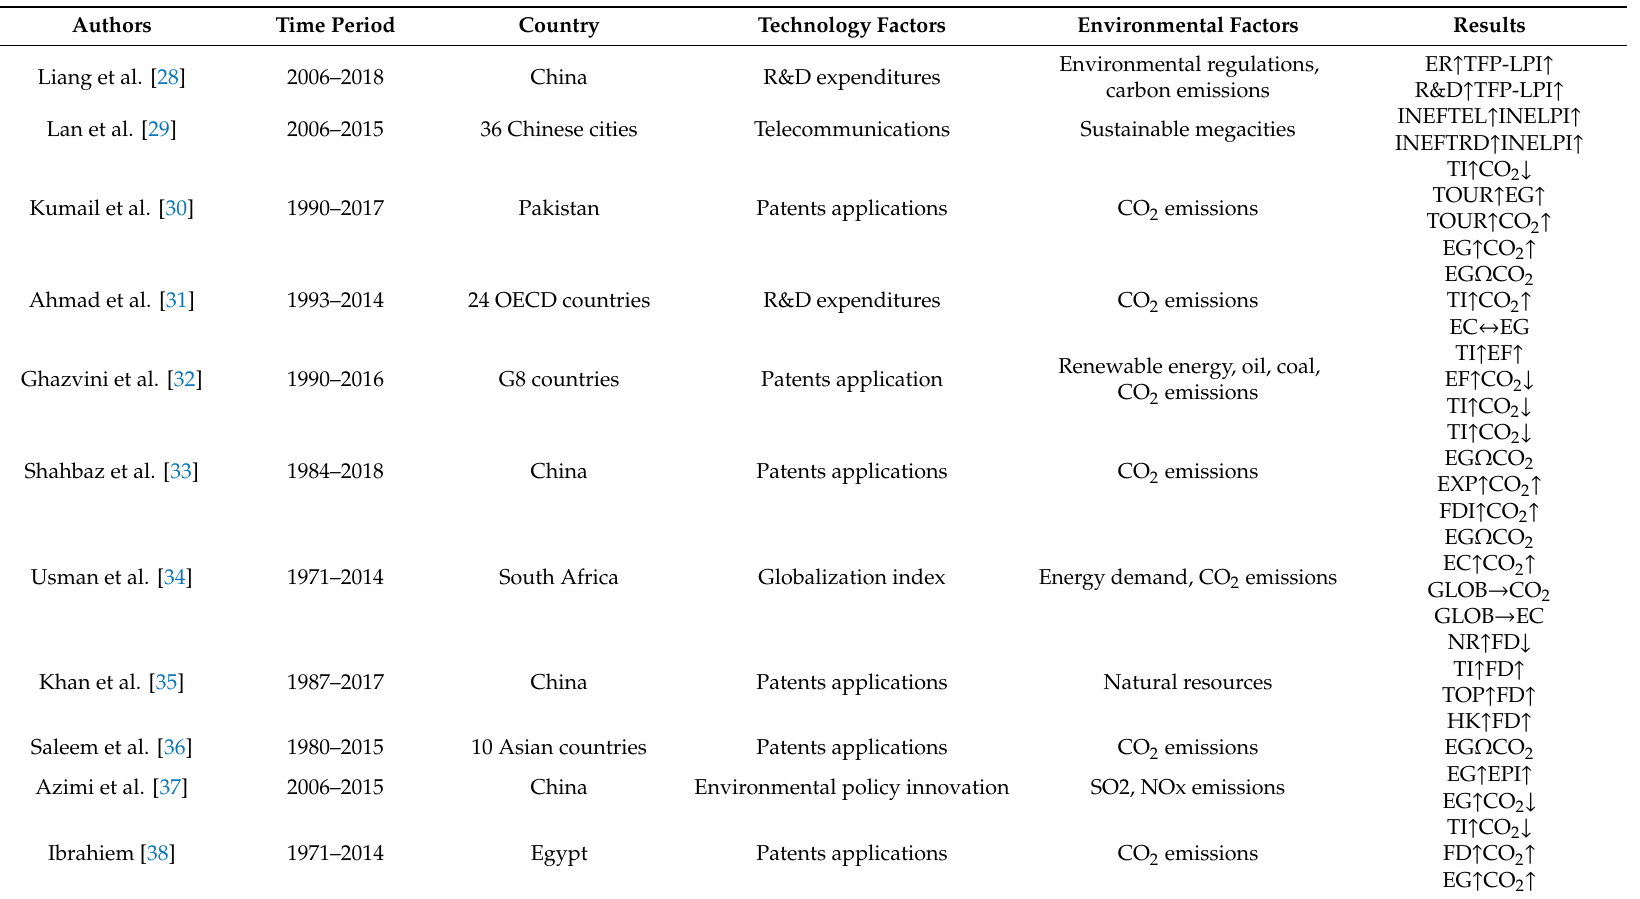
Table 1. Current Literature Review on Technology-Induced LPIs and Environmental Sustainability